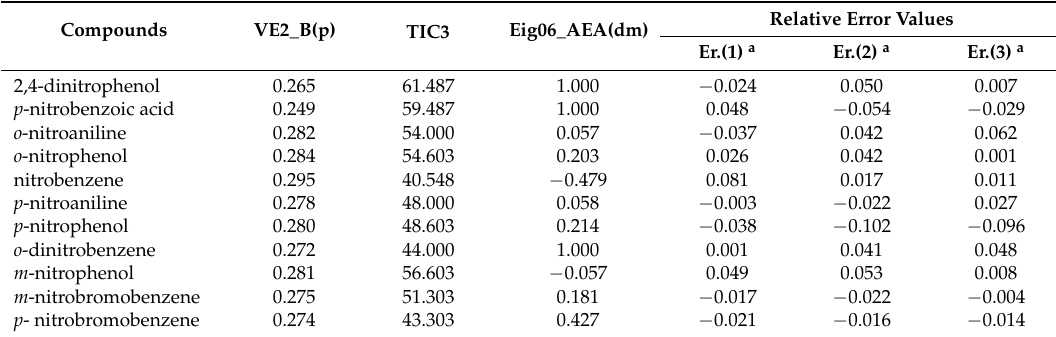
Table 4. Descriptors of nitro-substituted benzenes and the relative errors from QSAR models.